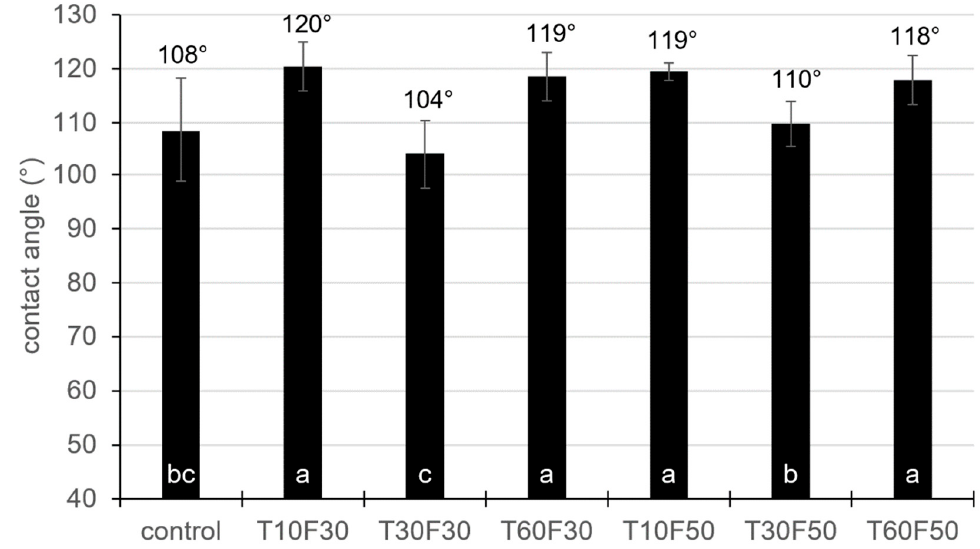
Figure 4. Effect of APD treatment on water contact angle on the surface of the wheat seeds (the same letter signs the variants that are not significantly different; vertical lines denote standard deviation bars).